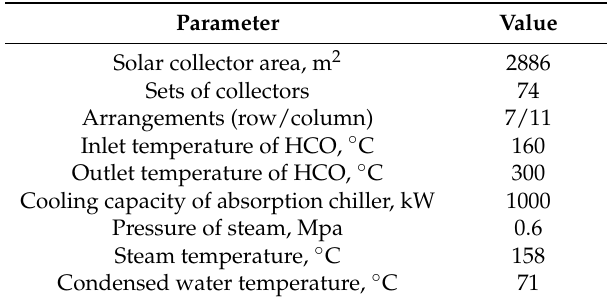
Table 5. Design parameters of the case study in the typical